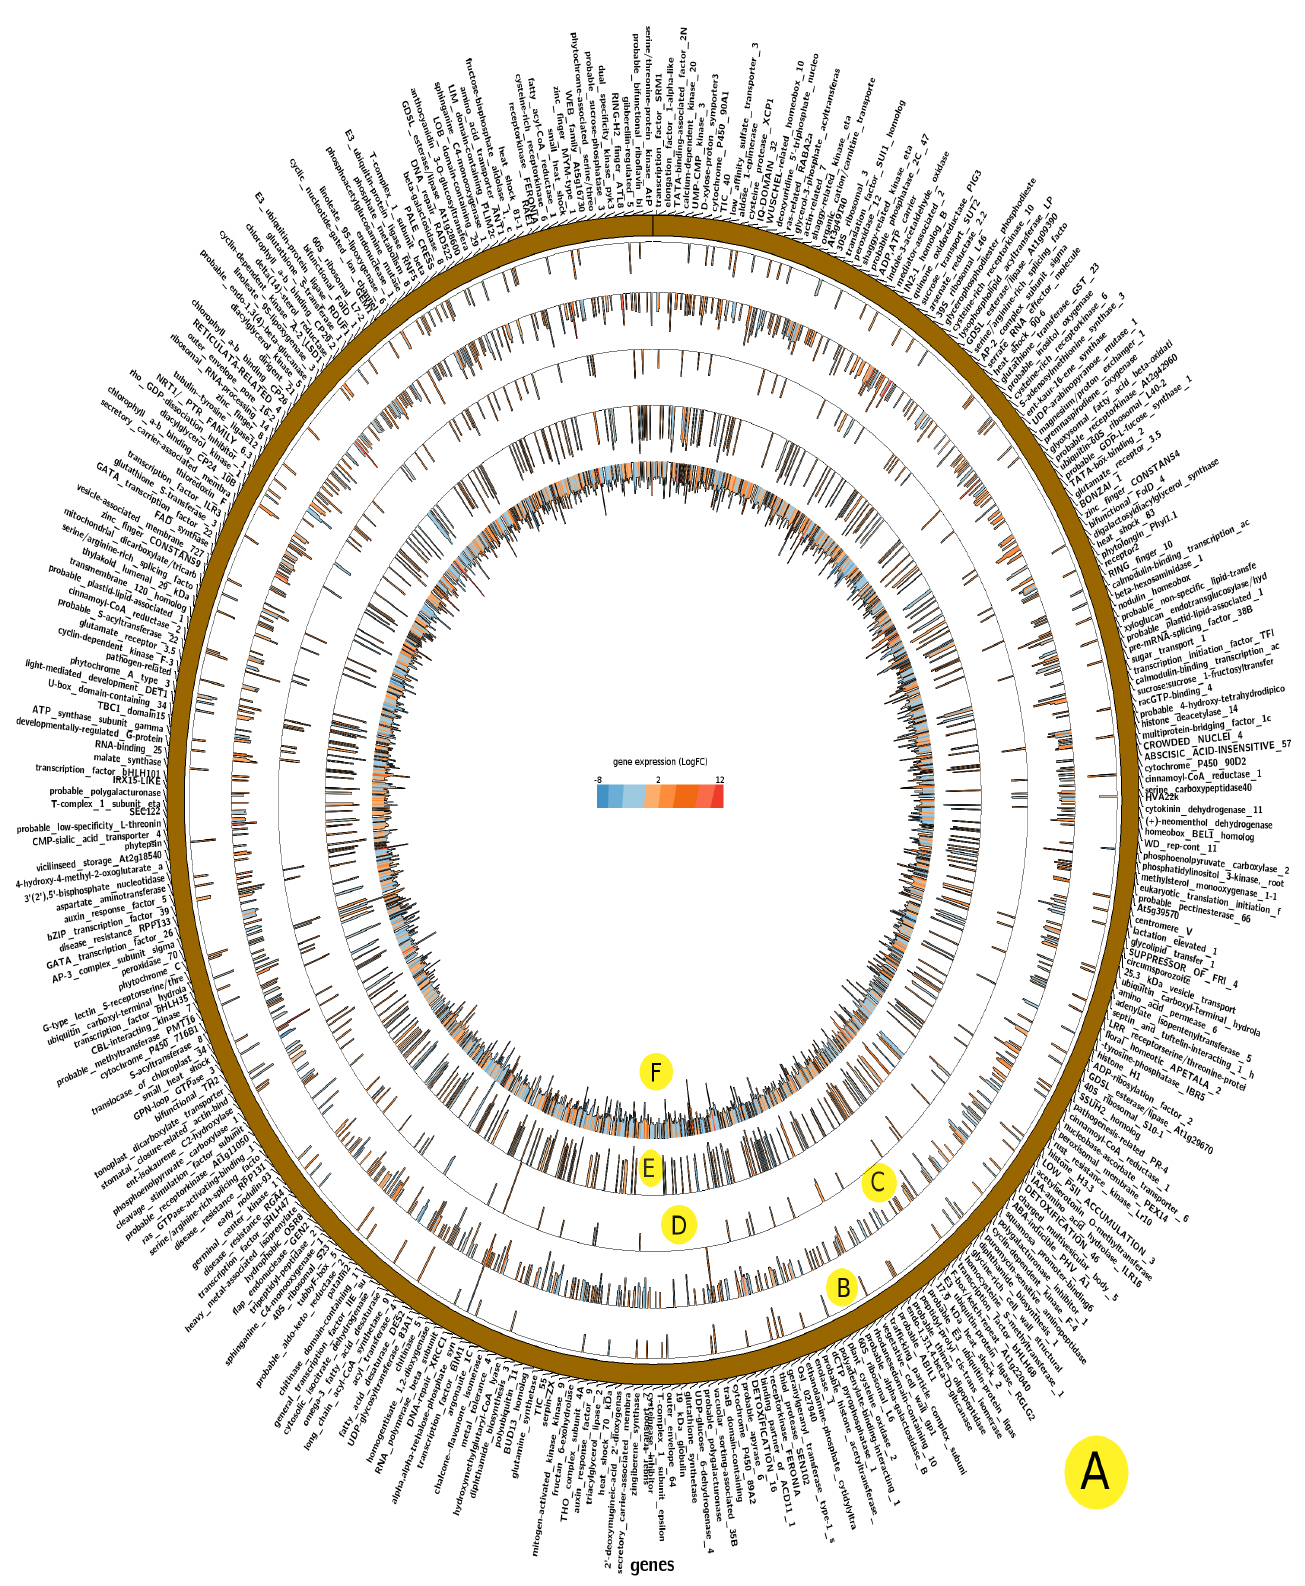
Figure 1. The gene expression and significance scores of DEGs of wheat genome. The gene expression (LogFC) and the significance (logpvalue) wheat genes (A) in D-ctrl (B), H-ctrl (C), HD-ctrl (D), HD-M (E), M-ctrl (F) gene profiles. The chart high and color stand for gene significance and expression, respectively.